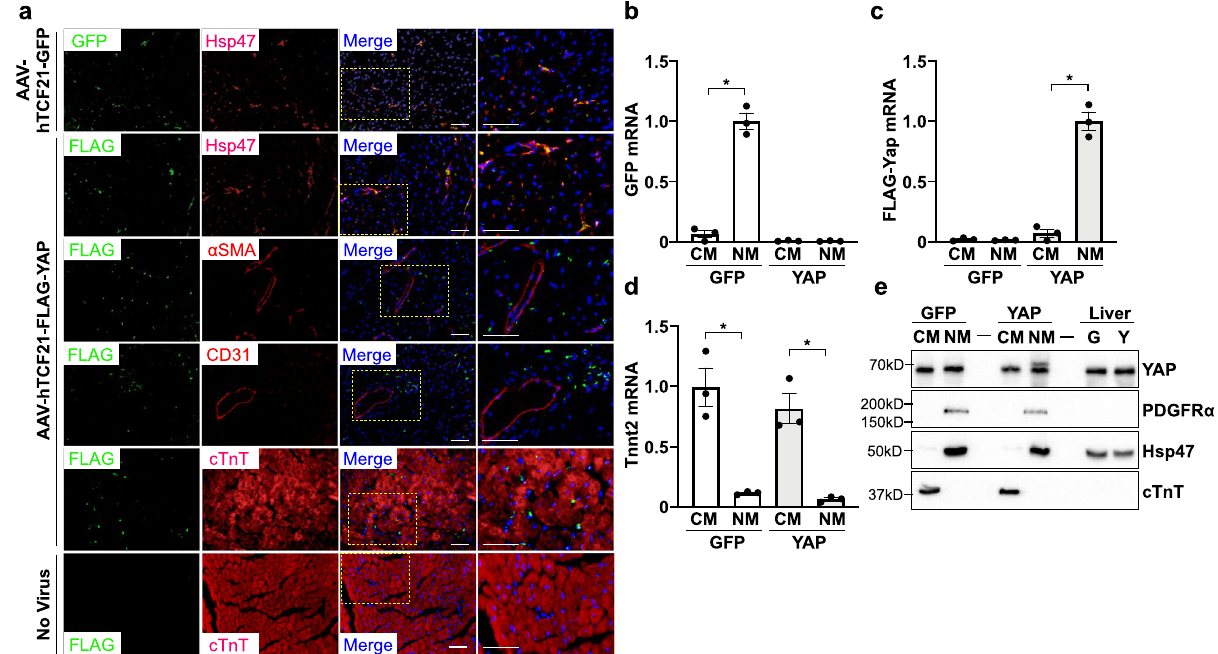
Figure 2. Characterization of AAV-hTCF21-GFP and AAV-hTCF21-FLAG-YAP expression in mouse hearts. Wild type C57BL/6J mice were administered AAV-hTCF21-GFP, AAV-hTCF21-FLAG-YAP, or no virus control. Hearts were excised and processed for immunostaining or cell isolation and fractionation. ( a ) Heart sections were stained to detect GFP or FLAG (green), and counterstained to visualize Hsp47, αSMA, CD31, or cardiac troponin T (red) and nuclei (DAPI). Right column panels are higher magnification merged images. Scale bar, 100 μm. ( b–e ) Heart cells were isolated from mice administered AAV-hTCF21-GFP or AAV-hTCF21-FLAG- YAP and separated into cardiomyocyte-enriched (CM) and non-myocyte-enriched (NM) fractions. RNA and protein were isolated for qPCR analysis and immunoblotting, respectively. ( b–d ) Expression of GFP, FLAG-Yap, and cardiac troponin T (Tnnt2) mRNA was determined by qPCR. ( e ) Protein fractions (20 μg per sample) were analyzed by western blot to detect YAP, PDGFRα, Hsp47, and cTnT protein levels. Whole liver homogenates from AAV-hTCF21-GFP and AAV-hTCF21-FLAG-YAP transduced mice (G and Y, respectively) were also analyzed (5 μg per sample). N = 3 mice/group. Representative blots are shown. *p < 0.05. Full-length blots are presented in Supplementary Fig.